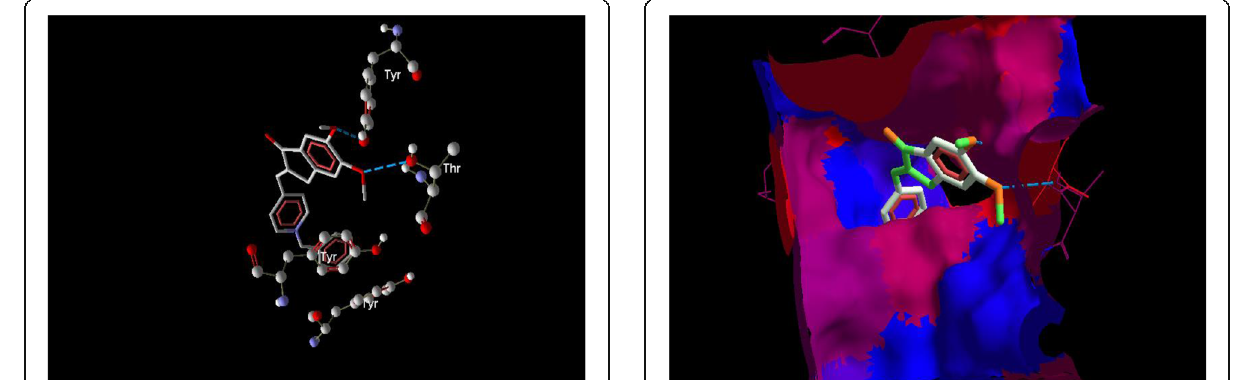
formation of 4-methyl-substituted coumarinyl pyrazole 5-one.